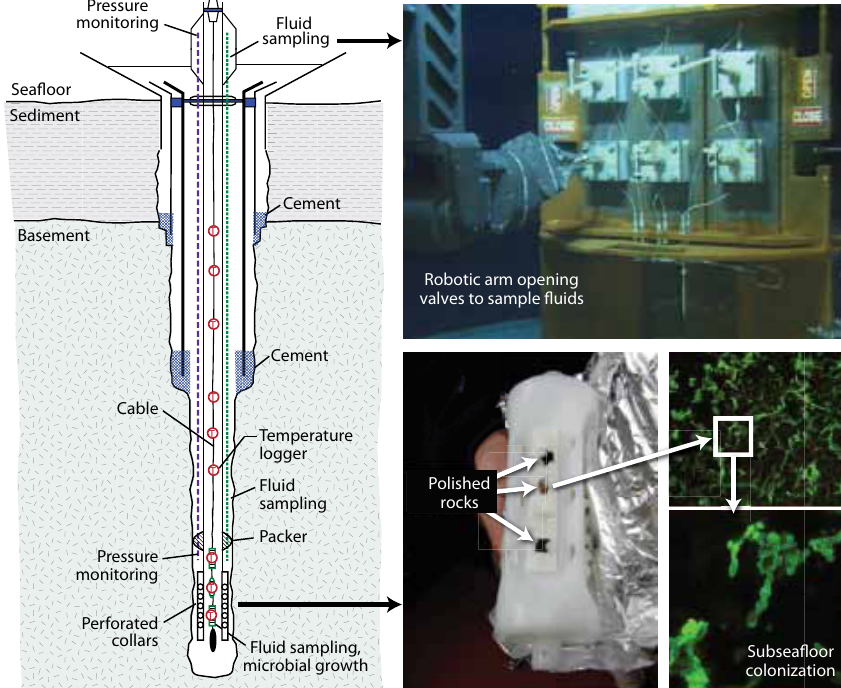
figure 5.5. schematic showing a long-term, subsea- floor observatory (corK, left; fisher, et al., 2011b) and examples of system servicing (top right) and experiments (lower right). seafloor and subseafloor instruments are installed when the observatory is initially deployed by a drillship, and can be recovered and replaced using a submersible or remotely oper- ated vehicle (upper right; photo courtesy Woods hole oceanographic institution). valves, samplers, and data loggers on the well head are accessed to download data and collect samples. downhole instru- ments are deployed for long-term fluid sampling and for subseafloor microbial colonization (lower right), which will allow the collection of relatively pristine communities from this remote biome. collection of microbes and high-quality fluid samples is generally not possible without establishment of an observa- tory, because of the influence of drilling, coring, and other